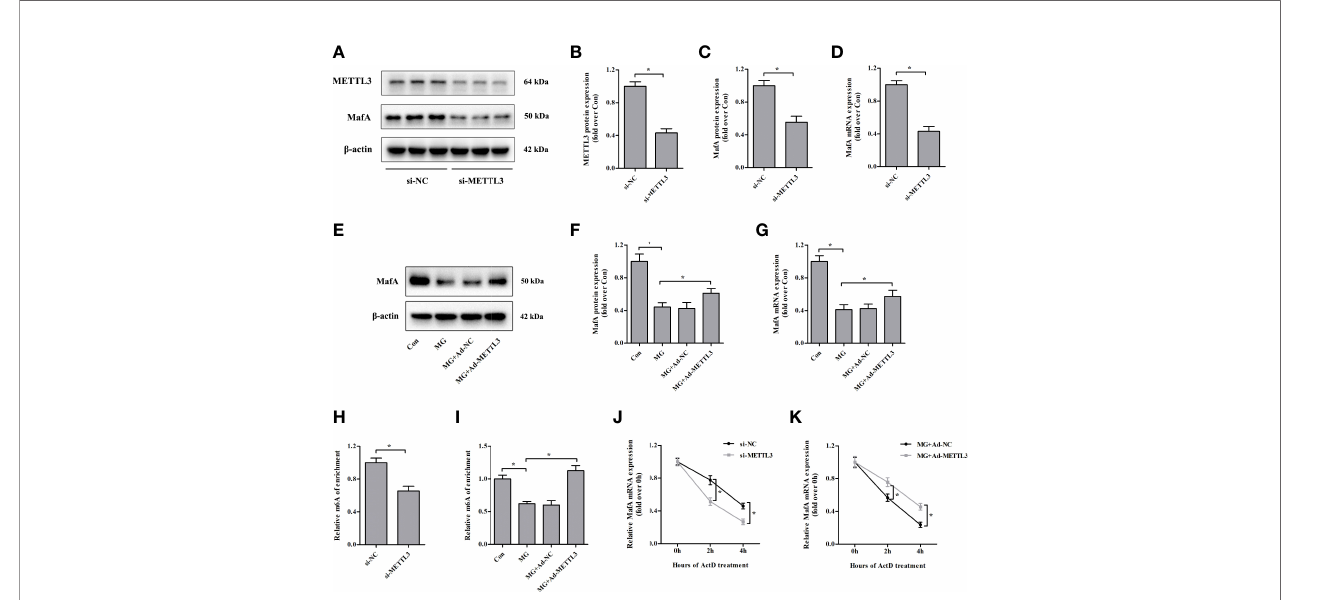
FIGURE 5 | Loss of METTL3 attenuates the expression of MafA. (A – D) METTL3 and MafA protein and mRNA levels were measured by immunoblotting and qPCR, respectively, in NIT-1 cells transfected with METTL3 siRNA (si-METTL3) or a nonspeci fi c control siRNA (si-NC), which was set to 1. (E – G) MafA protein and mRNA expression levels in NIT-1 cells transfected with Ad-METTL3 or a nonspeci fi c control adenovirus (Ad-NC) and treated with 1 mM of MG for 24 h were measured by immunoblotting and qPCR, respectively. (H, I) m 6 A MafA mRNA levels as detected by MeRIP-qPCR in NIT-1 cells transfected with si-METTL3 or si-NC, which was set to 1 (H) , or Ad-METTL3 or Ad-NC and treated with 1 mM of MG for 24 h (I) . (J, K) MafA mRNA as measured by qPCR in NIT-1 cells transfected with si-METTL3, si-NC, Ad-METTL3, or Ad-NC and treated with ActD to block transcription. Results are presented as the means ± SD of n = 3 – 4 independent experiments. * p < 0.05.